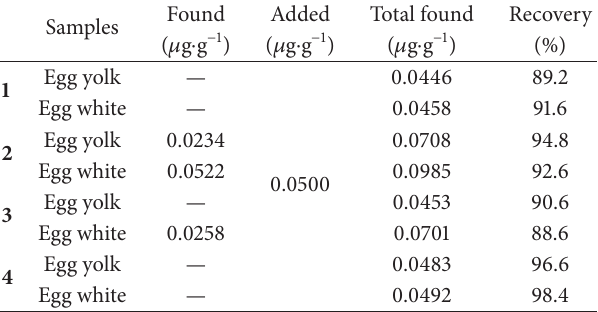
Figure 3: The effect of eluent on the recovery of ENRO in egg.